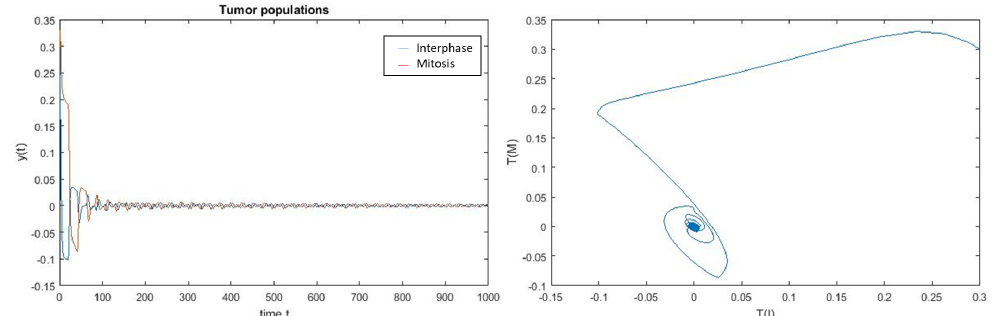
Figure 7. Tumour population with two immune response when τ = 20.3138 at E 0 = ( 0,0,15,0 ) .